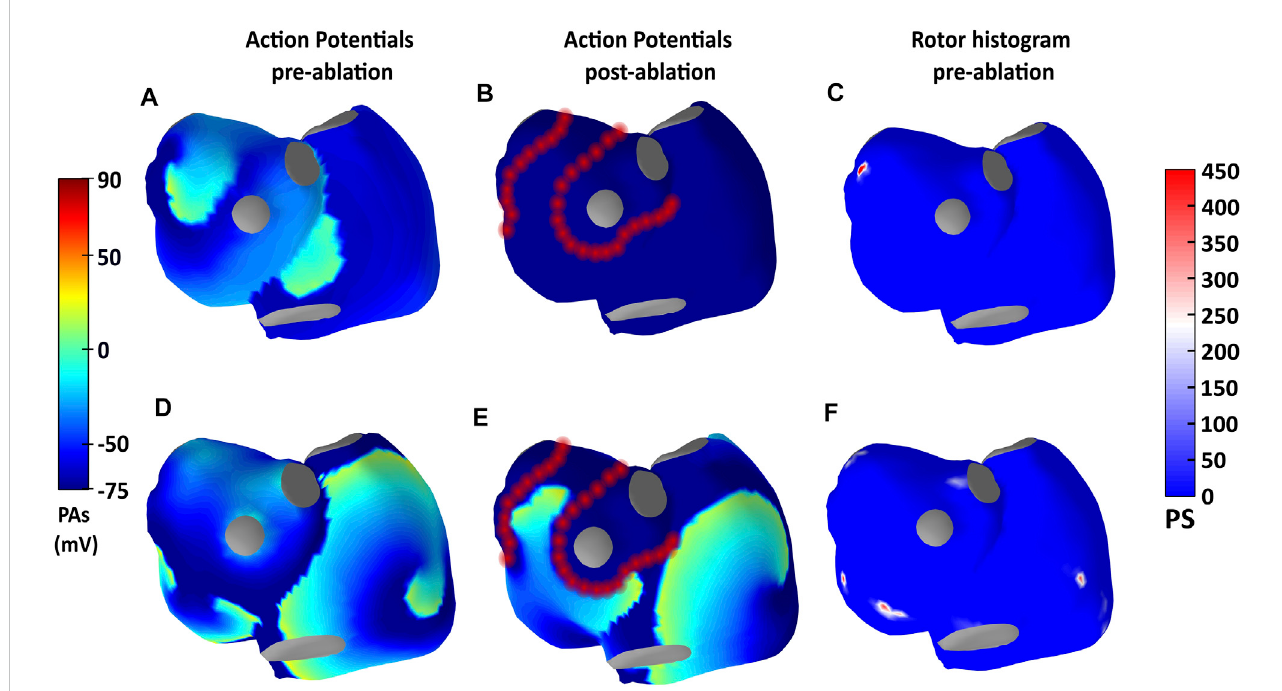
FIGURE 1 Information about simulations 1 and 2 is presented in the fi rst and second panel rows. Panels (A, D) show the simulated action potentials in an instant previous to the ablation, while panels (B, E) show the action potentials after ablation. In (C, F) , ECGI-derived rotor histograms of the pre-ablation periods are